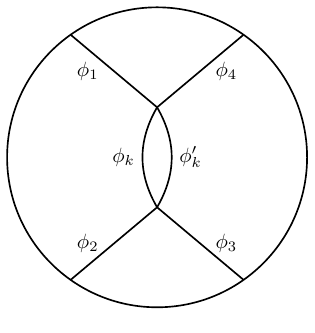
Figure 7 . Bubble Witten